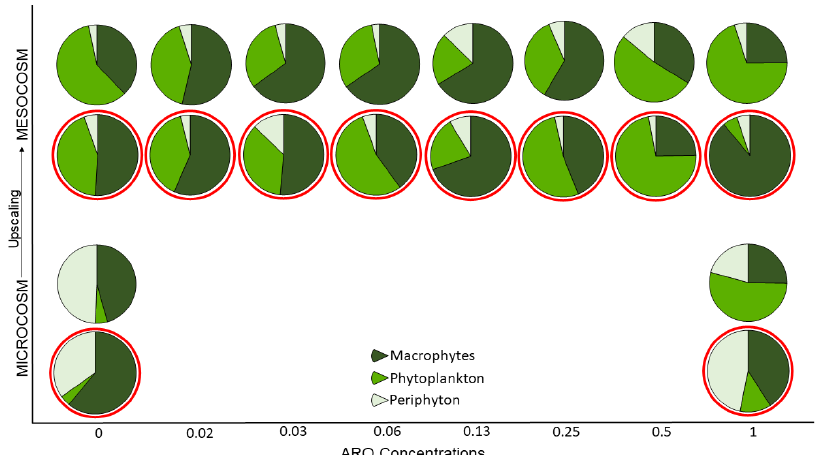
Figure 7. Microcosm–mesocosm comparison. Pie charts showing the relative proportion of primary producers in the microcosms (Munich well water treatments) and mesocosms when exposed to the ARO and the two temperatures. Heated treatments are represented by a red circle around the pie charts.